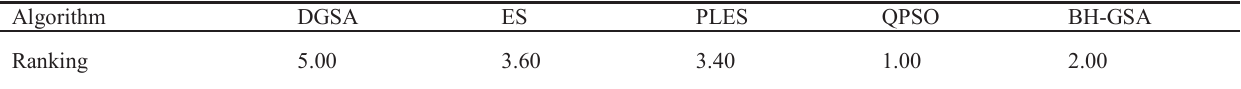
Table 16. Average ranking of algorithms based on the average best-so-far for unimodal test functions of set 2. Algorithm Ranking